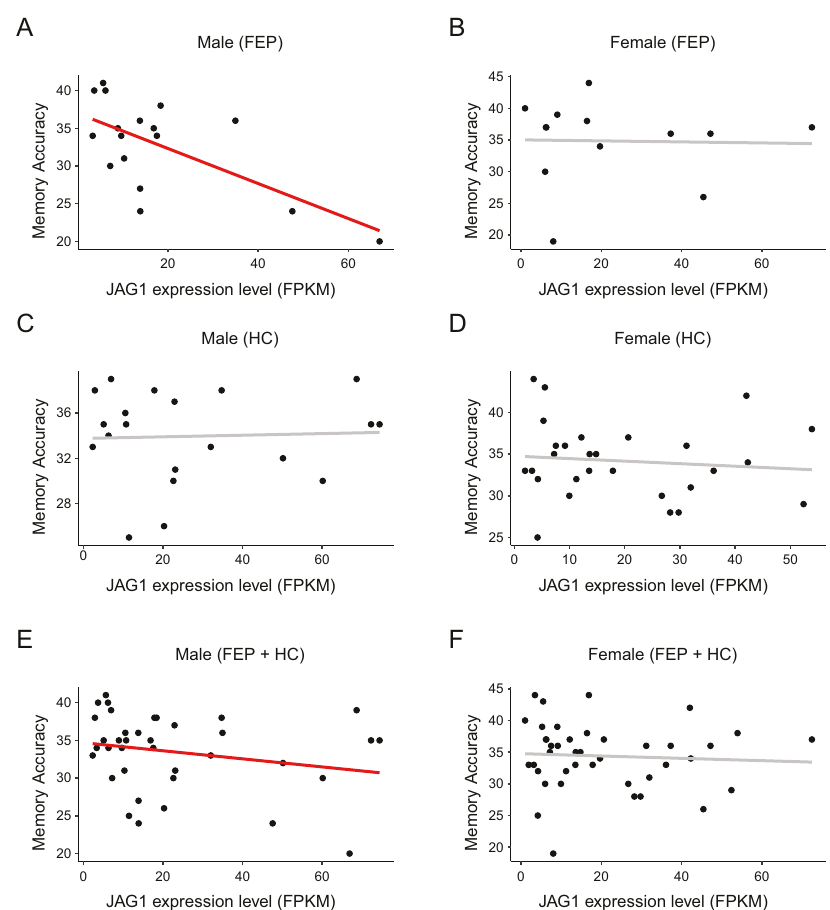
Fig. 3 Correlations between JAG1 expression and memory accuracy in the FEP cohort. A There was a signi fi cant correlation observed in male FEP patients. B There was no signi fi cant correlation observed in female FEP patients. C There was no signi fi cant correlation observed in male healthy controls (HC). D There was no signi fi cant correlation observed in female HC. E There was a signi fi cant correlation observed in male subjects (combining both FEP patients and HC). F There was no signi fi cant correlation observed in female subjects (combining both FEP patients and HC) Black dots represent individual subjects. A red line represents a signi fi cant correlation, while a gray line represents a correlation that did not reach the signi fi cance patients, in male healthy controls, or in female healthy controls The correlation between JAG1 expression and memory accuracy remained signi fi cant in males ( p -value = 0.04) when combining